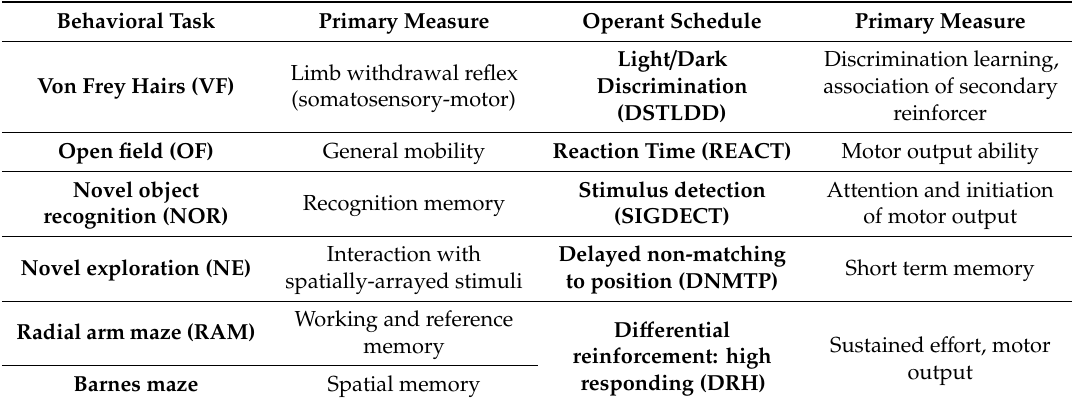
Table 1. Task summary and associated primary measures of behavioral evaluation tasks (left) and operant assessment schedules